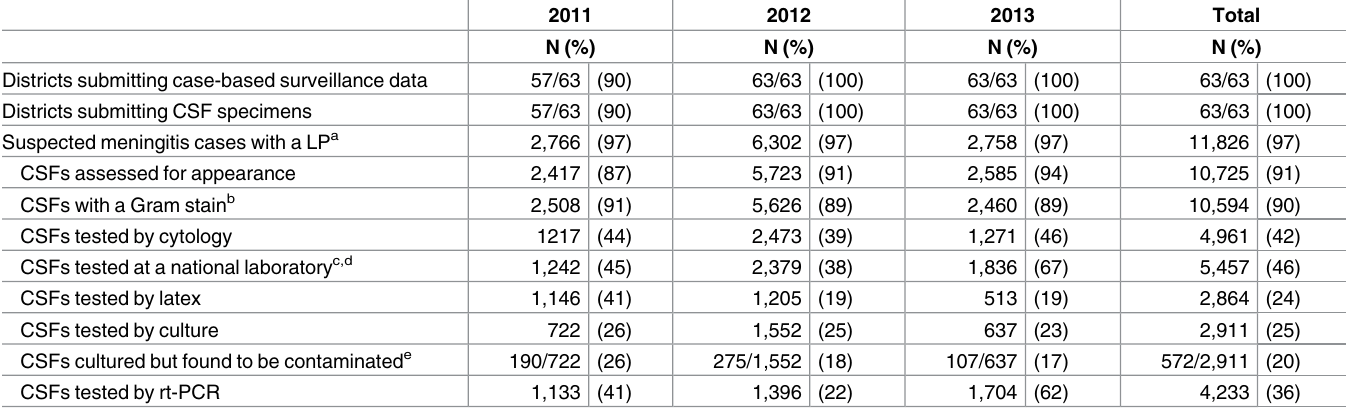
Table 1. National meningitis data quality and completeness indicators, Burkina Faso,